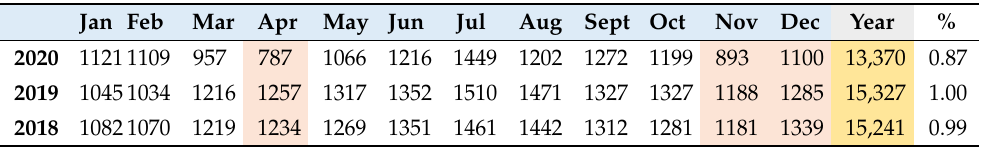
Table 7. Road transport emissions (ktCO 2 ). Lockdown periods